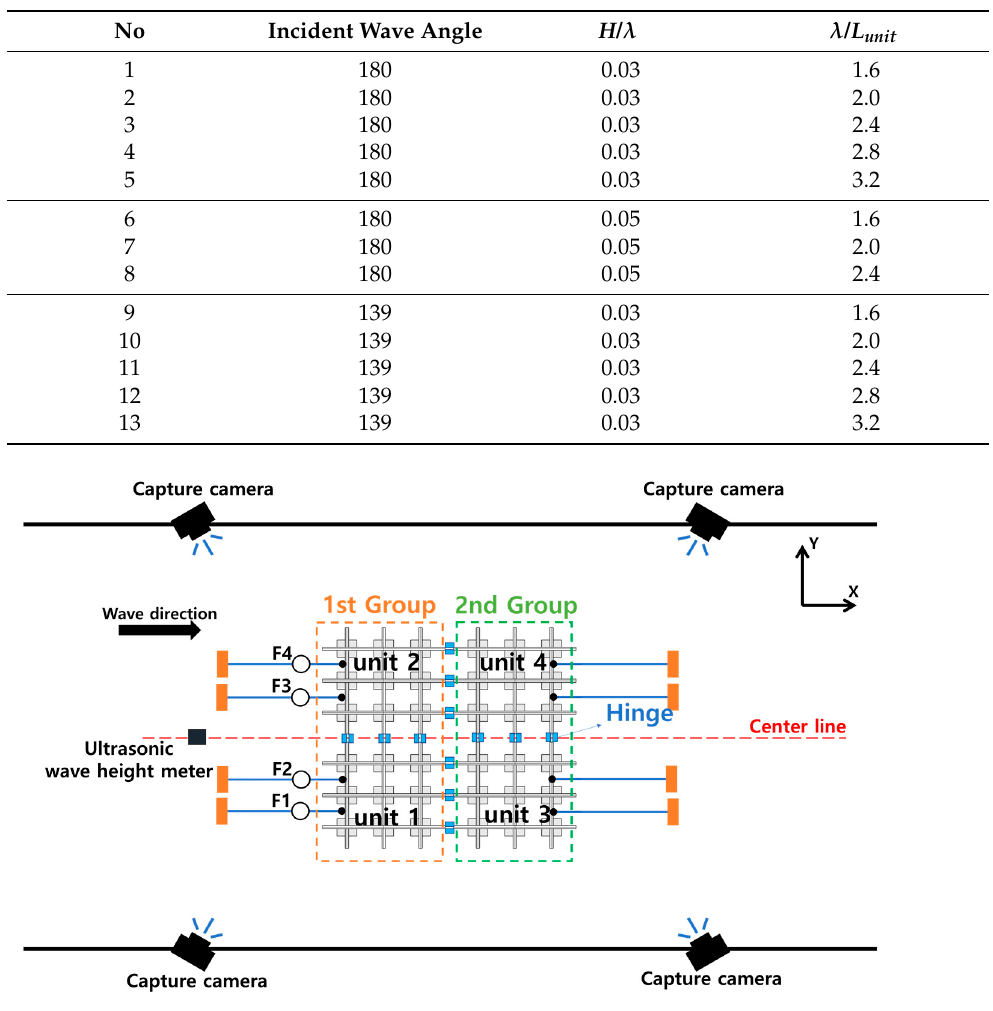
Table 2. Test conditions of the experiment.